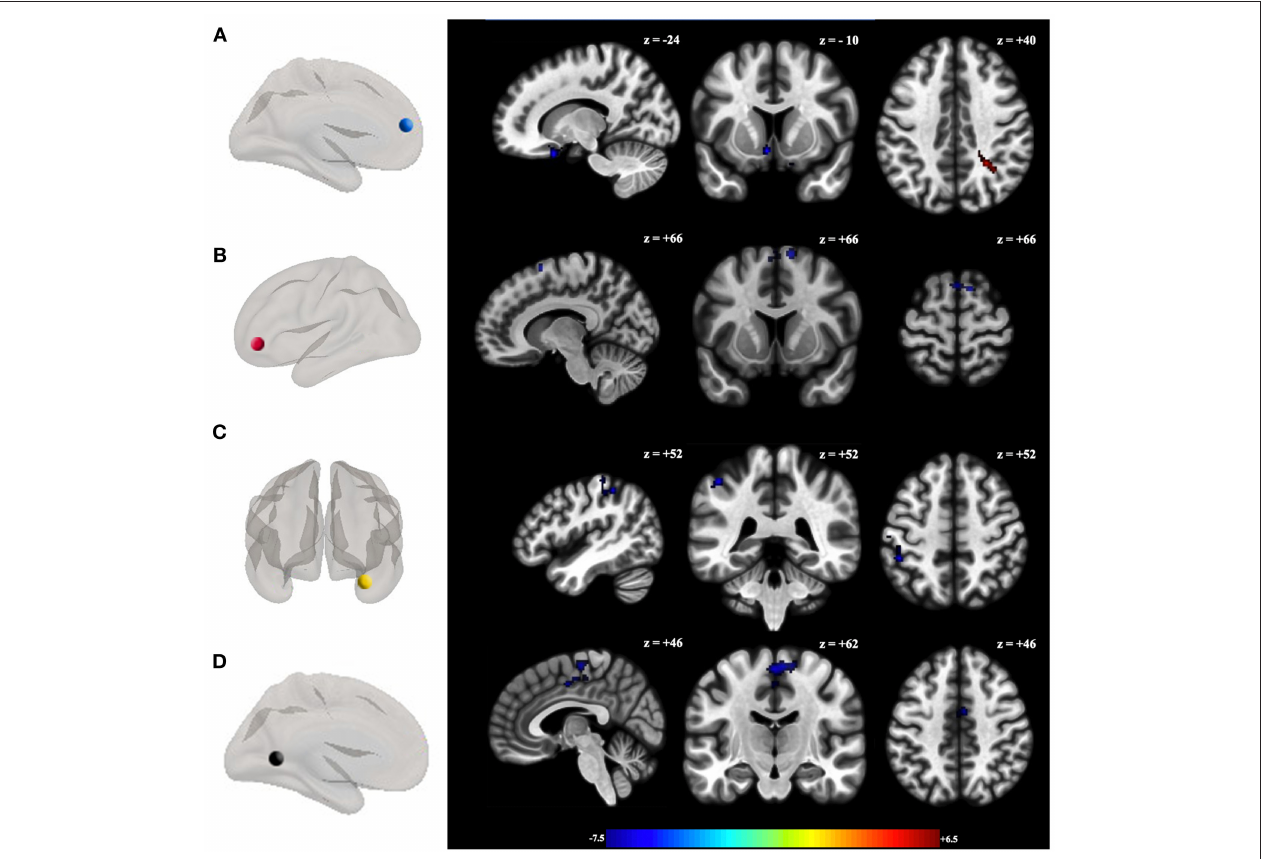
FIGURE 2 | Functional connectivity differences between groups (HC > BPD). Seeds showing significant functional connectivity differences between groups with the (A) left medial prefrontal cortex, (B) anterior cingulate cortex right; (C) right amygdala; and (D) inferior middle temporal gyrus between BPD patients and healthy controls with age as covariate. All analyzed contrasts where corrected by multiple comparisons using the false discovery rate (FDR) at 0.05. Blue and orange/hot represent decreased and increased functional connectivity, respectively. The color bar indicates the t -value. Details of the clusters are shown in Table 3